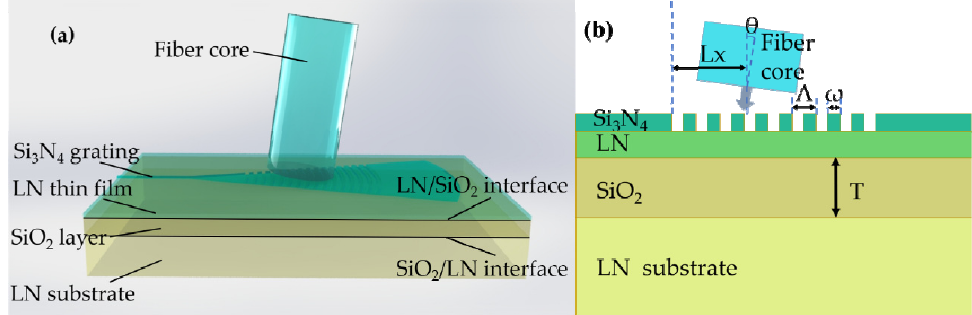
Figure 1. ( a ) The structure diagram, and ( b ) schematic cross-section of an Si 3 N 4 strip-loaded grating coupler on LNOI.